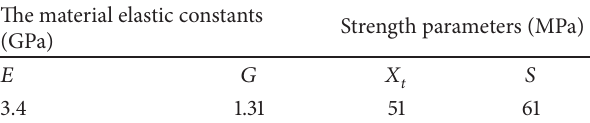
Table 2: Properties of bonding interface material. The material elastic constants